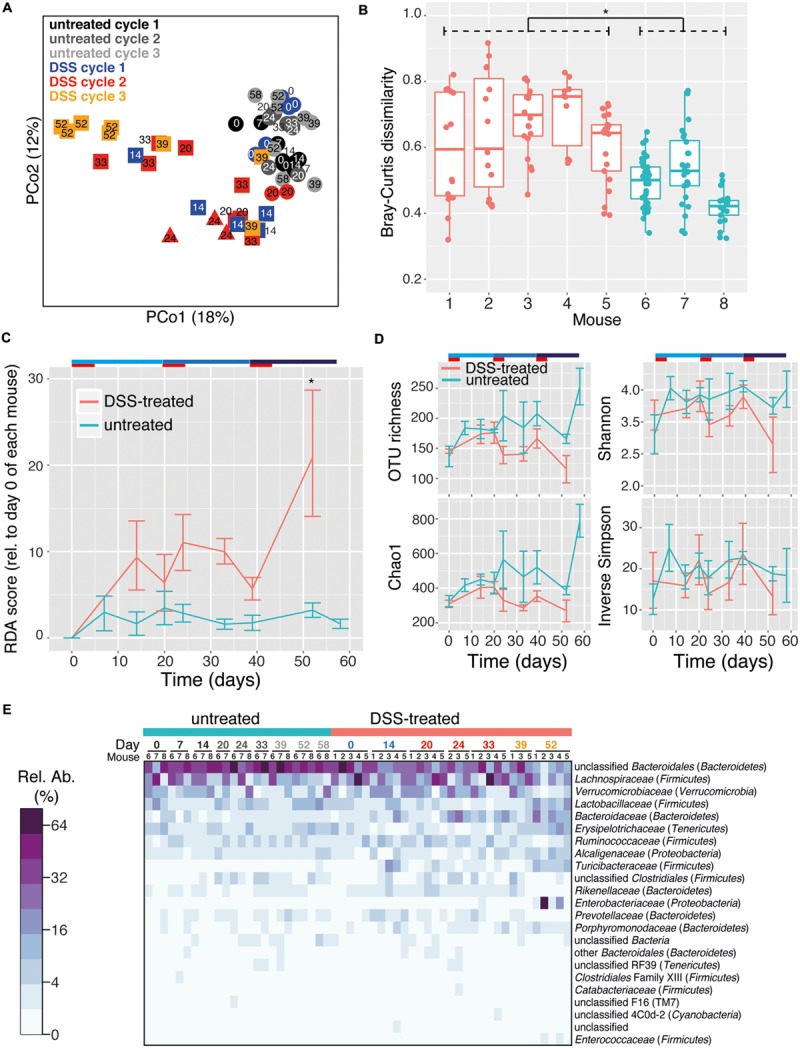
DSS treatment shapes fecal pellet intestinal microbiota composition and diversity. Fecal pellets were collected immediately upon defecation from untreated as well as DSS treated (in both acute and recovery phases) mice. (A) PCoA using the Bray–Curtis dissimilarity metric displays a trend toward clustering of samples based on number of DSS treatment cycles. This is statistically supported by the ANOSIM test (R = 0.3254, p = 0.001). Circles indicate untreated mice, triangles and squares indicate the acute and recovery phases of inflammation, respectively. (B) Microbiota stability per mouse, as determined by pairwise Bray–Curtis dissimilarity values calculated from multiple samples from each mouse. DSS-treated mice (red, #1–5) had significantly higher dissimilarity values as untreated mice (blue, #6–8), indicating a less stable microbiota composition throughout the duration of the entire experiment (Asterisk indicates p < 0.05). (C) The mean and standard deviation of the microbial community at successive time points relative to day 0 for each mouse based on redundancy analysis. Higher values indicate increasing divergence from the starting community. An asterisk signifies a difference between treated and untreated mice at that time point (p < 0.05). (D) Estimation of microbial community richness (observed OTU richness and Chao1 estimated richness) and diversity (Shannon and inverse Simpson indices) for each sample (mean and standard deviation shown). Observed OTU richness and Chao1 estimated richness were significantly reduced in the DSS treated group (ANOVA, p < 0.001). For all analyses sequence libraries were sub-sampled to 1000 reads. (E) Heatmap of the relative abundance of family-level taxa (rows) for each sample (columns). The abundance is shown in relative percent and the scale is square root transformed to allow visualization of less abundant groups. Families with at least 1% relative abundance in at least one sample are shown.